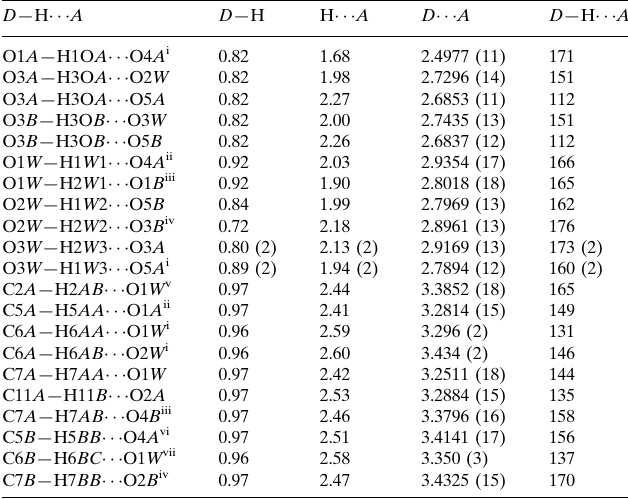
Hydrogen-bond geometry (A˚ , (cid:3)